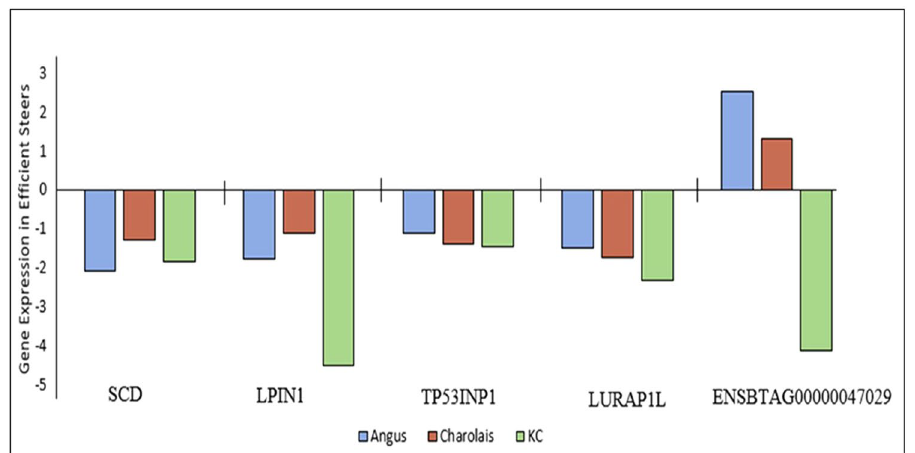
Figure 2. Expression profile (log 2 (Fold-change)) in low-RFI steers of the five differentially expressed (DE) genes common across all three